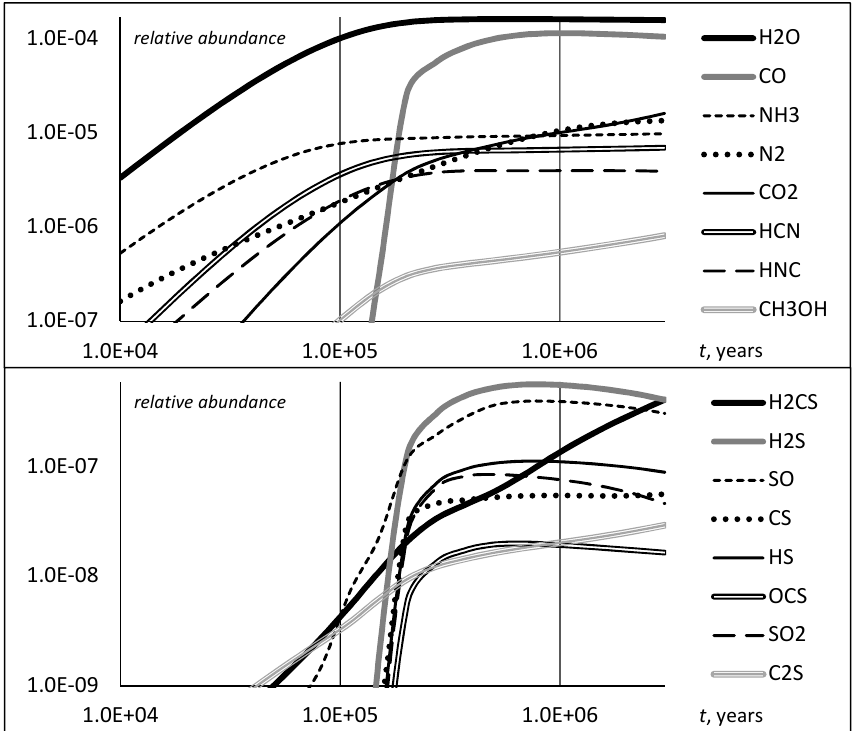
Fig. 2. Results of the cold chemistry model. Top panel – relative abundance of major ice species. Bottom panel – relative abundance of sulfur species in